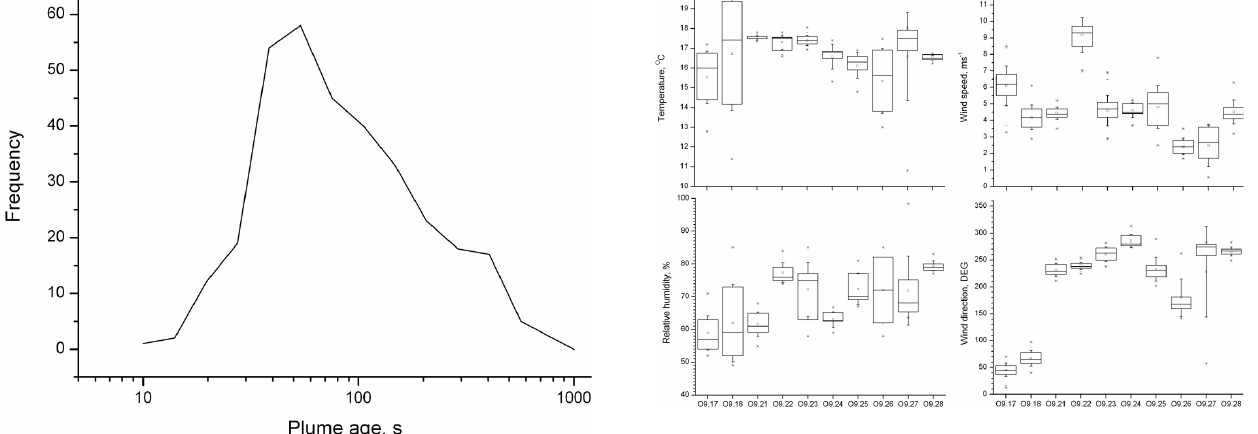
Figure 6. Summary of the meteorological conditions of the campaign as it can be 991 Fig. 6. Summary of the meteorological conditions of the campaign reflected by temperature (top left panel), relative humidity (bottom left), wind speed 992 as it can be reflected by temperature (top left panel), relative hu- and direction (top right and bottom right panels). Squares and horizontal bars 993 midity (bottom left), wind speed and direction (top right and bottom represent the means and medians respectively, while boxes show the range between 994 right panels). Squares and horizontal bars represent the means and the 1 st and 3 rd quartile. Error bars represent the standard deviations and stars show the 995 medians, respectively, while boxes show the range between the 1st and 3rd quartile. Error bars represent the standard deviations and minimum and maximum values. 996 stars show the minimum and maximum values.